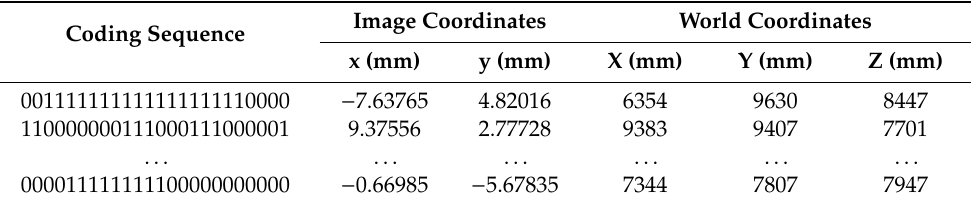
Table 1. Coding Sequences and Spatial Coordinates of the